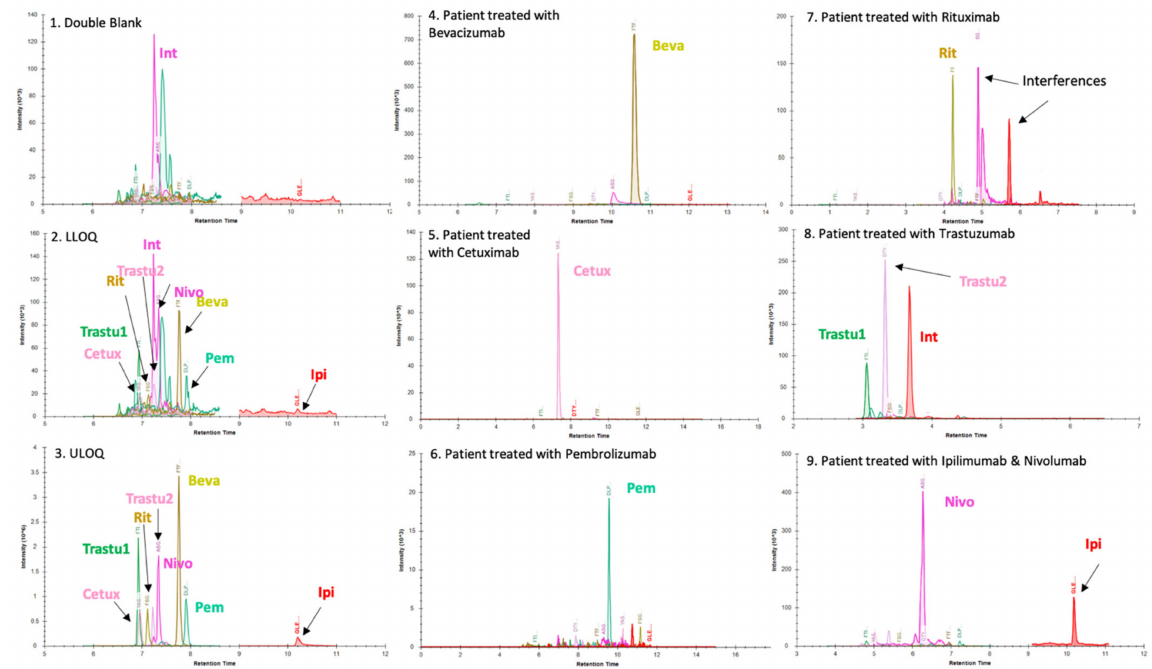
Figure 1. Panels ( 1 ), ( 2 ) and ( 3 ) present chromatographic profiles of double blank drug-free plasma matrix, lower limit of quantification (LLOQ) and upper limit of quantification (ULOQ), respectively. Int: interference. These chromatograms were obtained using a BioZen™ 2.6 µ m Peptide XB–C18 LC column and the LC–MS parameters were those described in the Materials and Methods section. Two proteotypic peptides were selected for trastuzumab because both are unique and give intense signals in LC–MS. For the other mAbs, the list of proteotypic peptides was limited because of the sequence homology of mAbs with endogenous IgG (other peptides are not specific). In this context, a single peptide was selected in the quantification method of all mAbs except trastuzumab. Panels ( 4 ), ( 5 ), ( 6 ), ( 7 ), ( 8 ) and ( 9 ) display chromatograms obtained from plasma samples of patients treated with bevacizumab (Beva) ( 4 ), cetuximab (Cetux) ( 5 ), pembrolizumab (Pem) ( 6 ), rituximab (Rit) ( 7 ), trastuzumab (Trastu1 & Trastu 2) ( 8 ) and combination therapy nivolumab (Nivo) + ipilimumab (Ipi) ( 9 ). The retention times of mAbs shown in these panels are different with those observed in panels ( 1 ), ( 2 ) and ( 3 ) because of the use of different chromatographic systems and columns in each laboratory using the kit. Thus, panels ( 1 ), ( 2 ), ( 3 ) were analyzed on SCIEX 6500QTRAP by Promise Proteomics. Panels ( 4 ) and ( 9 ) were analyzed on SCIEX 6500 QTRAP by PROMISE Proteomics with distinct LC parameters. Panels ( 5 ), ( 6 ), ( 7 ) and ( 8 ) were analyzed on a THERMO TSQ Altis at Cochin hospital (Paris, France). Importantly and as visible on ( 1 ), ( 2 ) and ( 3 ), an interfering signal (Int) is present for nivolumab peptide when analyzing plasma samples with a QQQ mass spectrometer. It elutes very close to the peak of interest. This interference can be separated with an appropriate gradient. Lower limit of quantification and